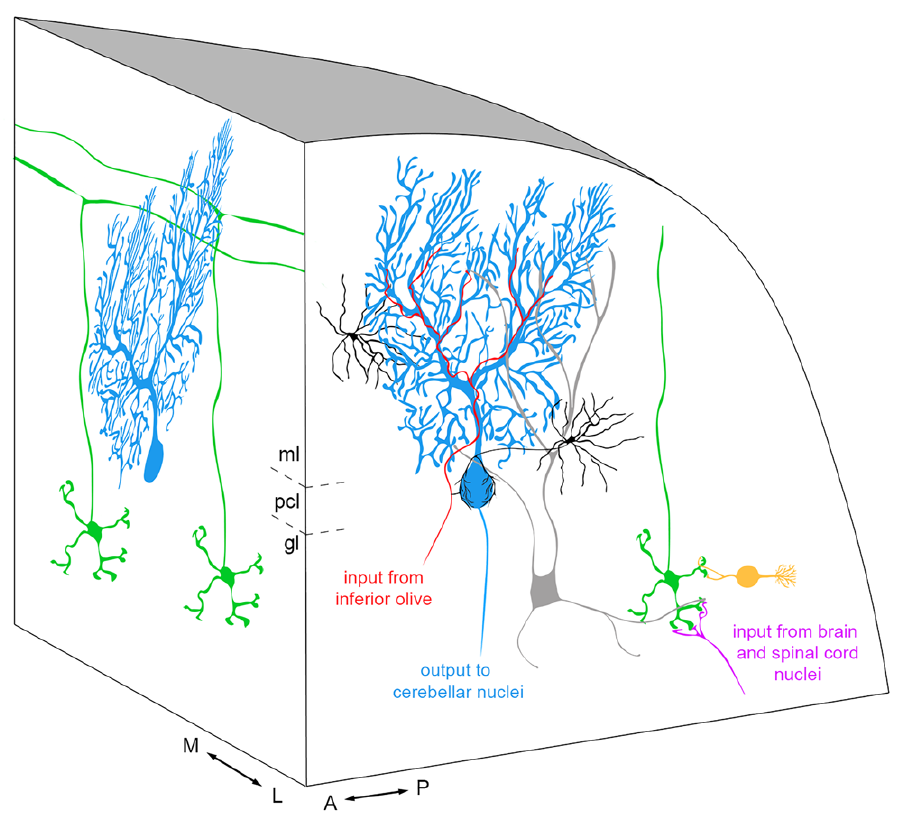
Figure 1. Architecture of the cerebellar cortical circuit. A three-dimensional schematic of the cerebellar cortex illustrates the repeating basic circuit of Purkinje cells (blue), granule cells (green), climbing fiber afferents (red), mossy fiber afferents (magenta), stellate and basket cell interneurons (black), Golgi cell interneurons (gray), and unipolar brush cell interneurons (orange). Granule cell axons ascend to bifurcate into parallel fibers along the mediolateral axis that contact the dendrites of Purkinje cells. Purkinje cell axons deliver the output of the circuit